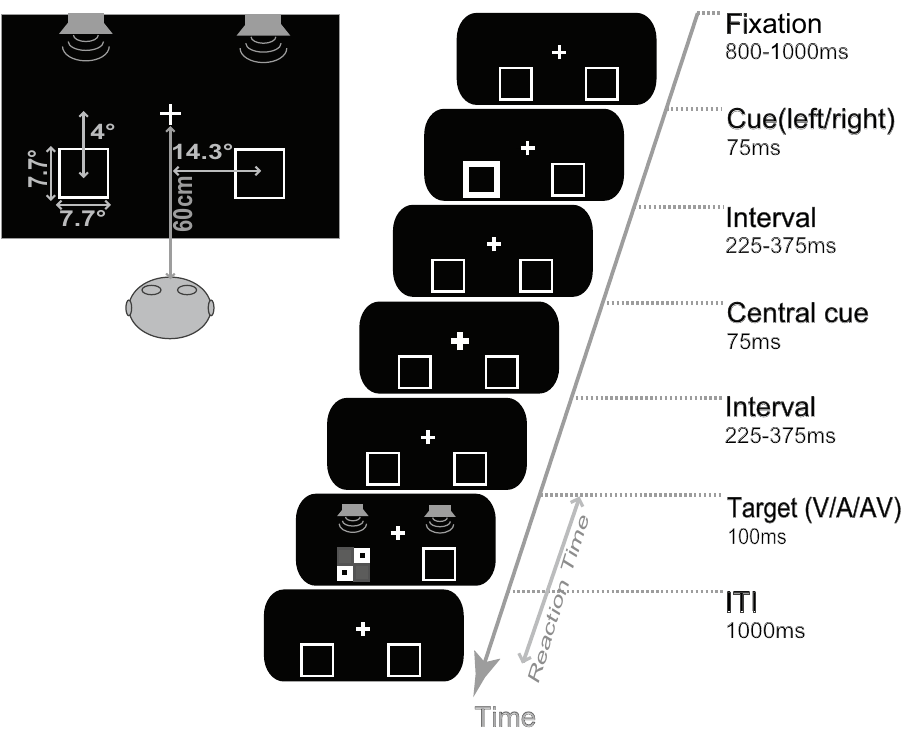
Figure 1. Illustration of the stimuli and experimental procedure. The size and position of the stimuli are shown in the left panel. The sequence of events and their duration (starting from the top) in the valid location of the visual (V) target condition are illustrated in the right